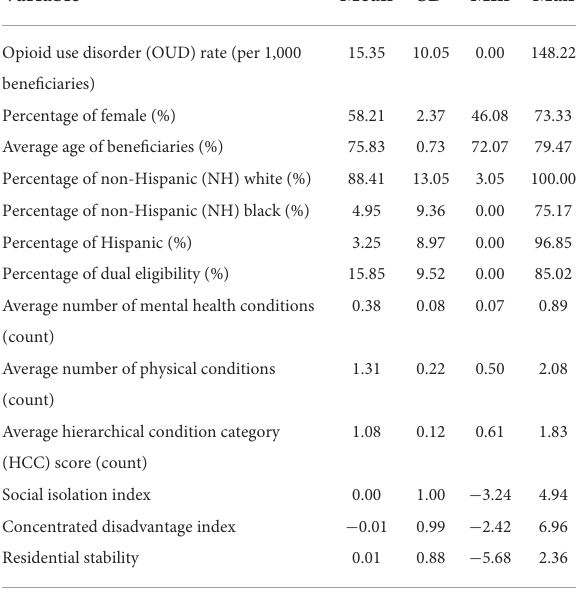
TABLE 1 Descriptive statistics of the variables used in this study ( N =